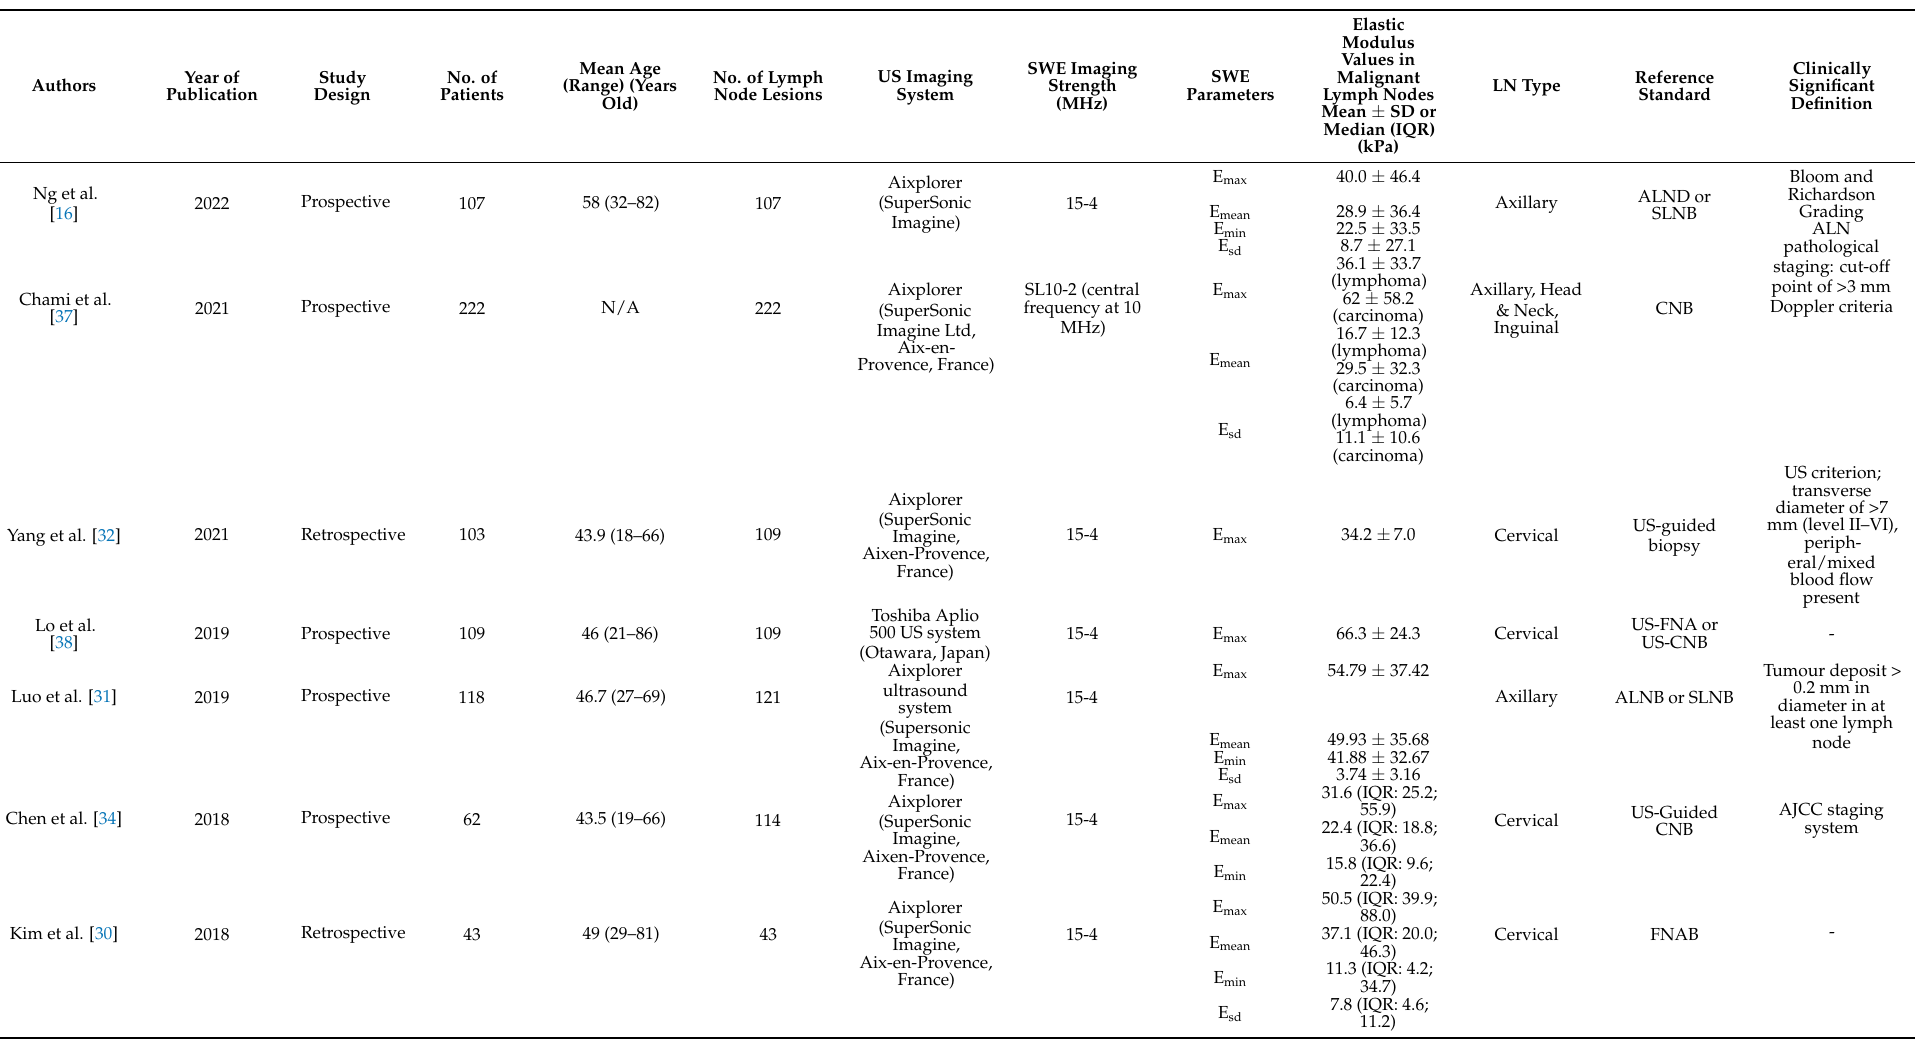
Table 1. Study characteristics of included